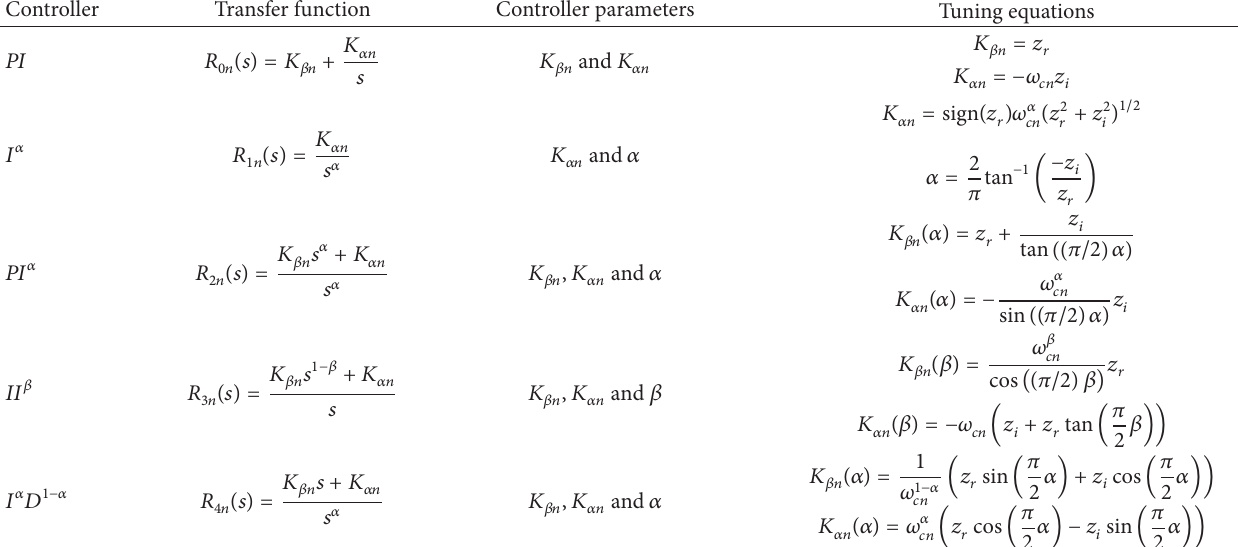
Table 1: Tuning equation